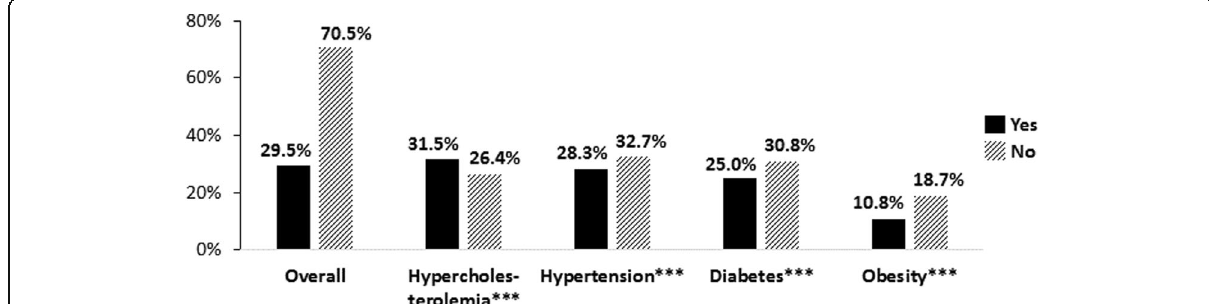
Fig. 1 Overall and Individual Disease-Specific Rates of CAM Use. Overall: [Yes = Used CAM of any kind regardless of disease condition; No = Did not use CAM]; For individual disease conditions: [Yes = Used CAM and had the disease; No = Used CAM but did not have the disease];